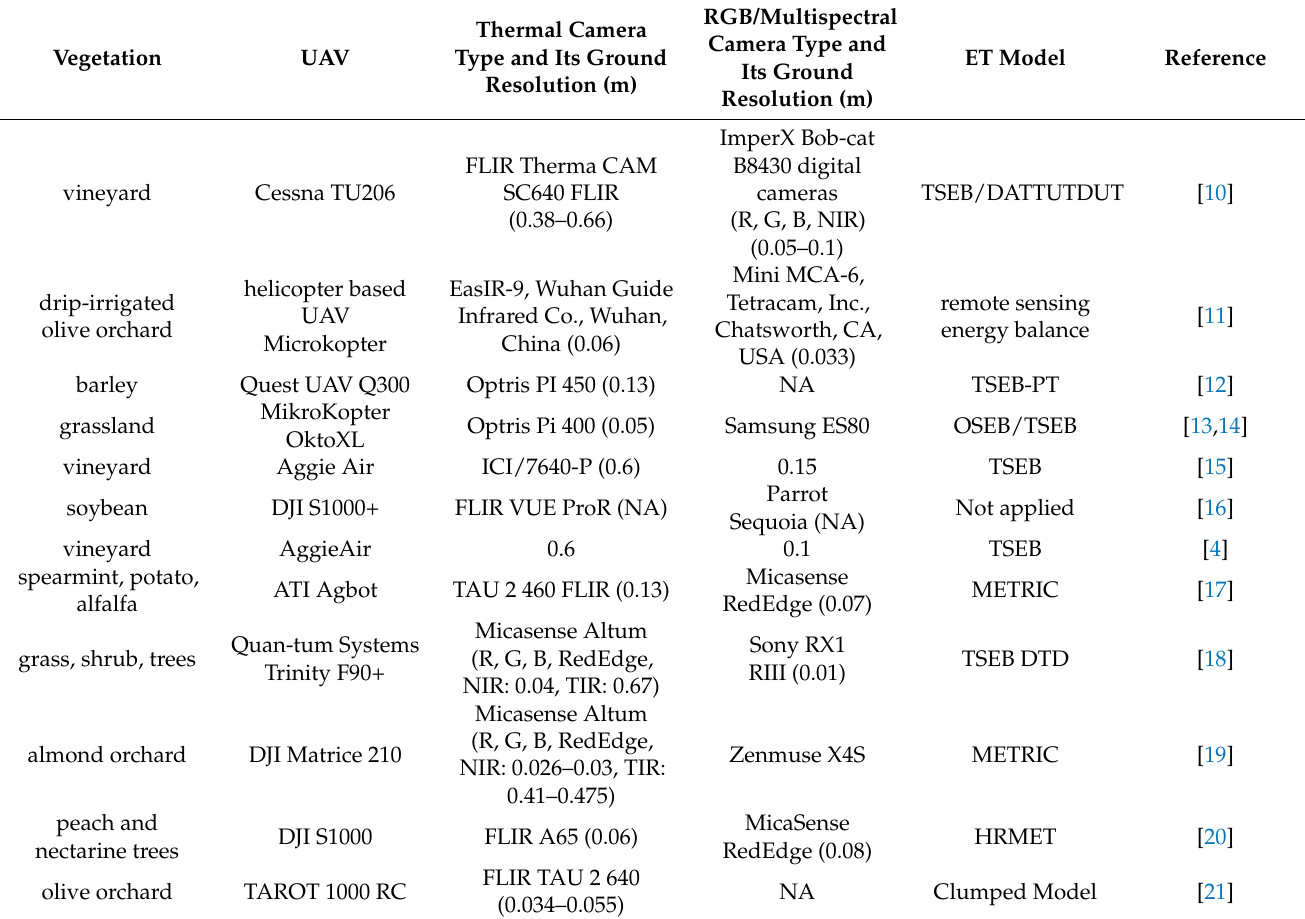
Table 1. Summary of the studies addressing UAV based ET modelling. Type of vegetation, UAV, thermal, and RGB or multispectral camera, and the ET model used are included in the table. After the type of camera the ground resolution (m) is given in